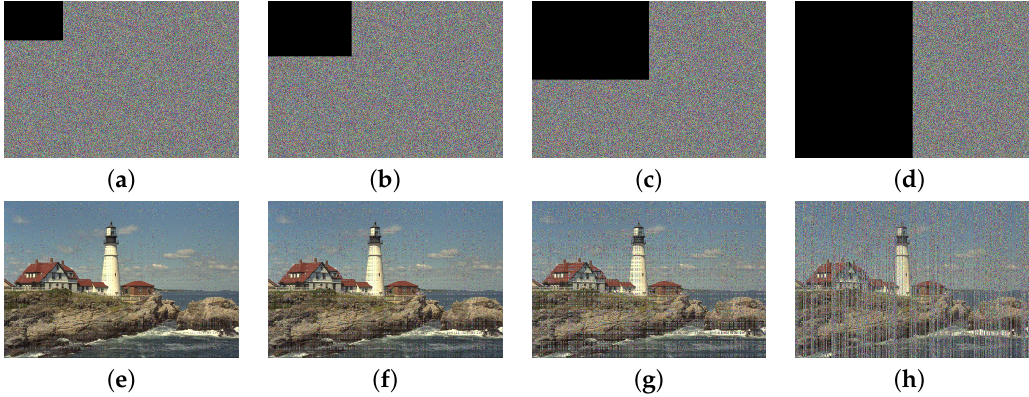
Figure 9. Occlusion attacks: encrypted images with ( a ) 6.25%, ( b ) 12.5%, ( c ) 25%, and ( d ) 50% data loss; their corresponding decrypted images ( e – h ).